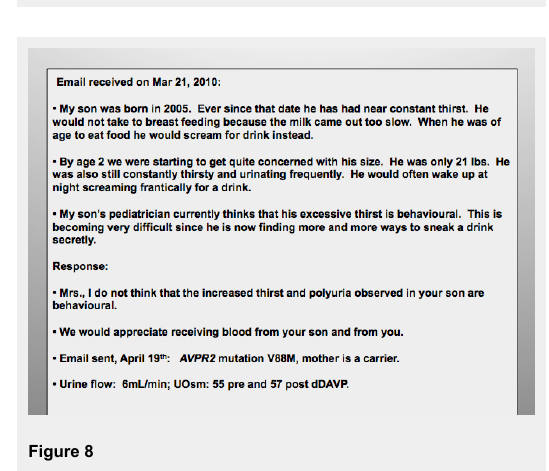
Schematic representation of the V 2 receptor and identification of 193 putative disease-causing AVPR2 mutations. Predicted amino acids are shown as the one-letter amino acid code. A solid symbol indicates a codon with a missense or nonsense mutation; a number indicates more than one mutation in the same codon; other types of mutation are not indicated on the figure. There are 95 missense, 18 nonsense, 46 frameshift deletion or insertion, 7 inframe deletion or insertion, 4 splice-site, and 22 large deletion mutations, and one complex mutation. (From: Bonnardeaux A, Bichet DG. Inherited disorders of the renal tubule. In: Brenner BM (ed). The Kidney. 8th ed. New York: Harcourt Health Sciences; 2008. p. 1382‒1419. © Elsevier, Oxford, UK, with kind